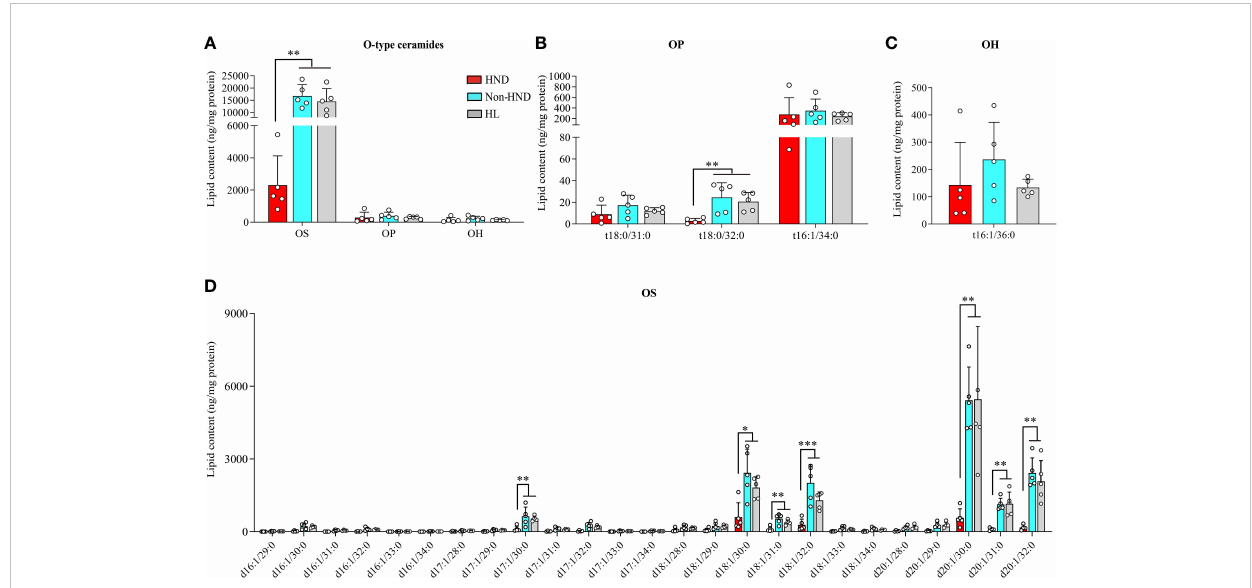
FIGURE 6 w -Hydroxyceramides (O-type ceramides) contents in human stratum corneum. (A) Overall O type ceramides (B) OP type ceramides, (C) OH (t16:1/ 36:0) ceramides, and (D) OS type ceramides. ( fi ve replicates for each column, Mann-Whitney U Test, (A) OS; p = 0.0018, OP; p = 0.3833, OH; p = 0.2839, (B) t18:0/31:0; p = 0.2516, t18:0/32:0; p = 0.0021, t18:0/34:0; p = 0.538, (C) t16:1/36:0; p = 0.2839, (D) d17:1/30:0; p = 0.0055, d18:1/30:0; p = 0.0117, d18:1/31:0; p = 0.005, d18:1/32:0; p = 0.0006, d20:1/30:0; p = 0.0029, d20:1/31:0; p = 0.0029, d20:1/32:0; p = 0.0012) Abbreviations: